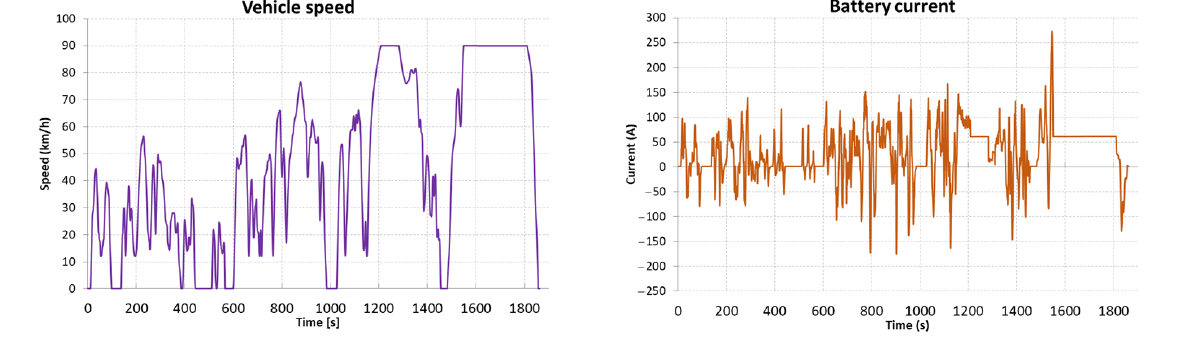
Figure 12. WLTP-90 results of simulation tests for the 4 × 4 drive system with Type 1 energy storage. In Figure 11 the results of the WLTP test of a 4 × 4 equipped with Type 1 energy storage (LFP prismatic cells) are shown. The range on a fully charged energy storage is 229.3 km, with an average energy consumption of 272.2 W/km. The profile of this test is relatively strenuous due to the driving speed required, which translates into energy